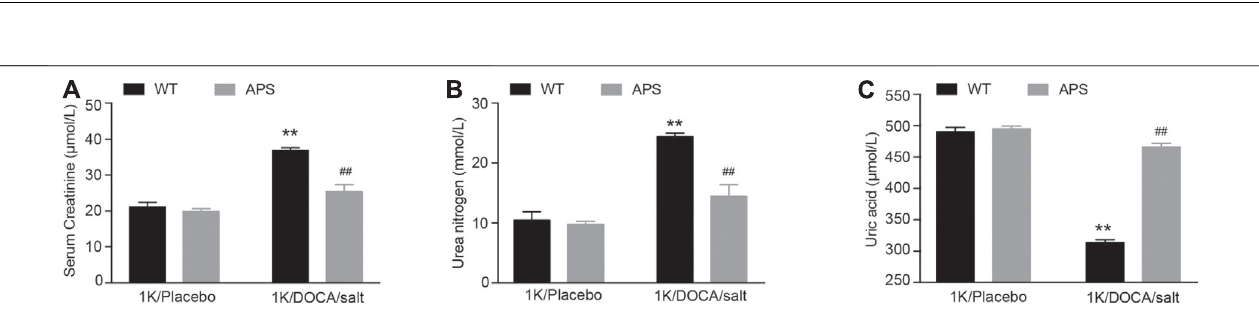
FIGURE4| APSimprovesthekidneyfunctioninDOCA-treatedmice. (A) Thelevelofserumcreatinineineachgroup( n (cid:1) 6pergroup). (B) Thelevelofureanitrogen in each group ( n (cid:1) 6 per group). (C) The level of uric acid in each group ( n (cid:1) 6 per group). ** P < 0.01 versus control mice. ## P < 0.01 versus DOCA + APS mice.